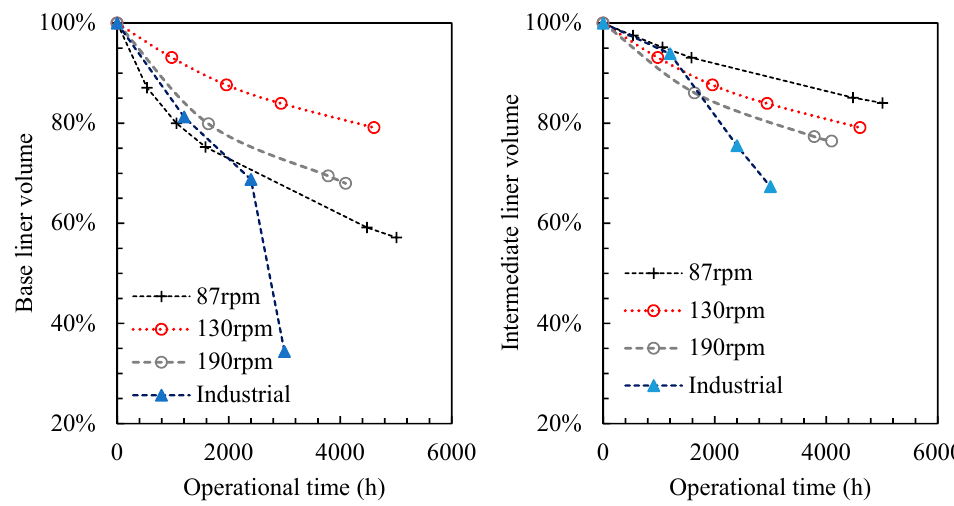
Figure 21. Model predicted and measured values of base and intermediate liner volume during operational time (h).